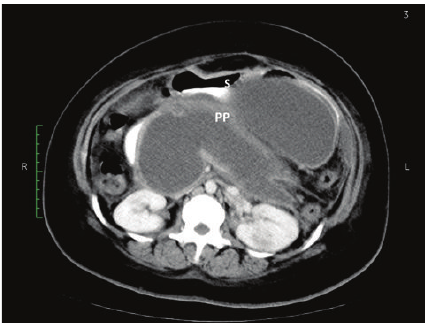
Figure 1: Axial slice of a CT scan of a patient with a large pancreatic pseudocyst (PP) demonstrating its apposition onto the posterior wall of the body of the stomach (S).